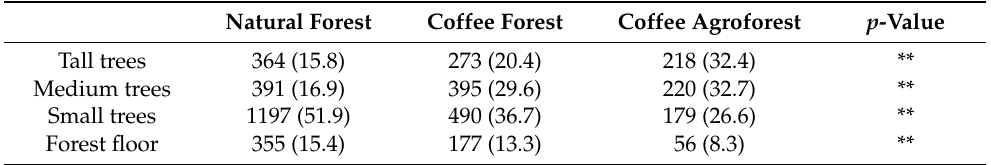
Table 4. Summarised number of trees in the natural forest, coffee forest and coffee agroforest (tall tree (≥3 0 m), medium tree (15 m to 30 m), small tree (0.5 m to 15 m), forest floor (<0.5 m).